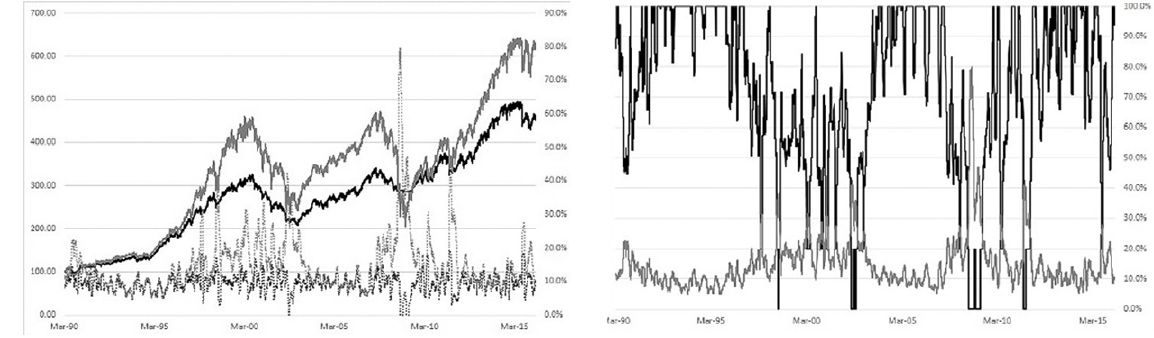
Figure 3. Comparative results for the DTVS STD portfolio and the S&P 500 Note: The left side presents the path of DTVS STD (solid black line) and of S&P 500 (solid gray line), and the DTVS STD rolling standard deviation (dotted black line) and the S&P rolling standard deviation (dotted gray line). The right side presents how the equity exposure of the DTVS STD (solid black line) changes with respect to the volatility of the S&P 500 (solid gray